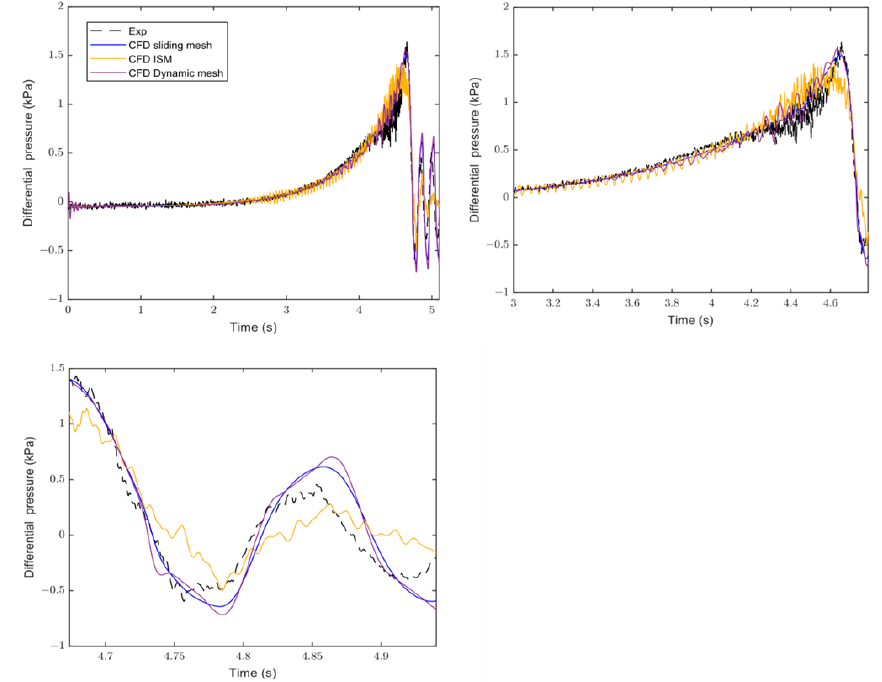
Figure 9. The variation of differential pressure with time during the valve closure between two cross-sections 11 m and 15 m upstream of the valve.